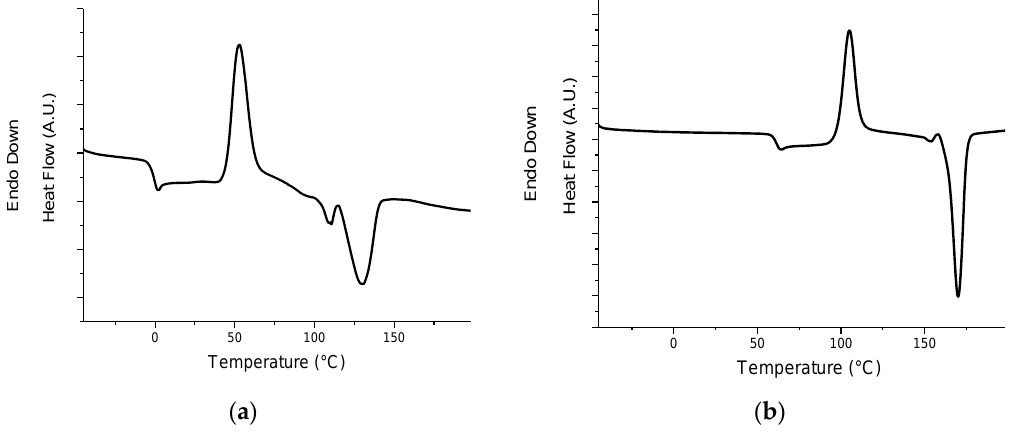
Figure 2. DSC thermograms recorded during the second heating scan for virgin ( a ) PHB and ( b ) PLA. Table 2. Thermal properties of neat blend and Syn-containing systems.